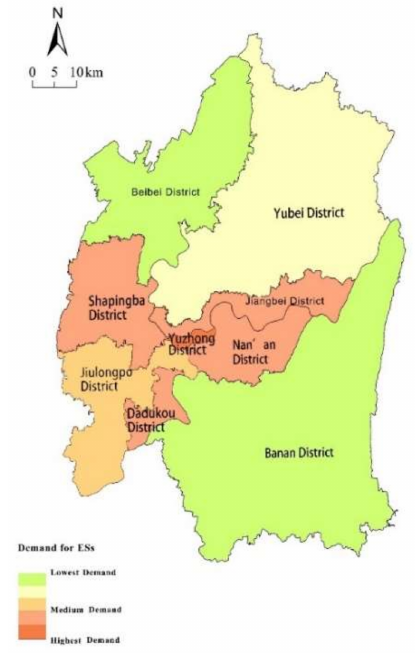
Figure 6. Spatial distribution of ESs demand.